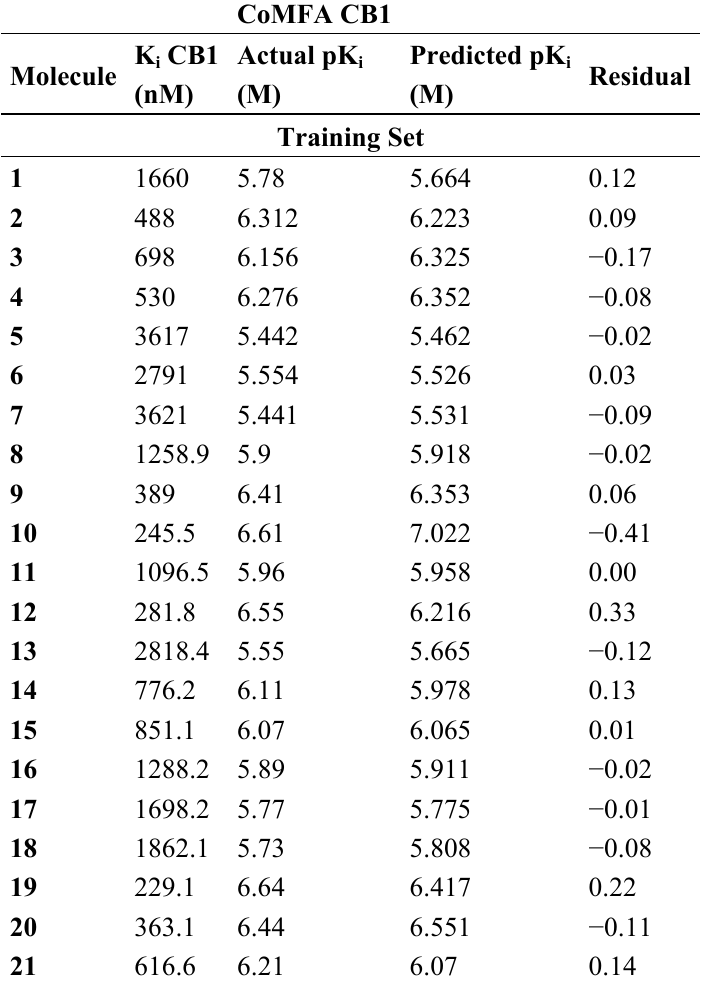
Table 2. Experimental and predicted activity for training and test set in the CB1 and CB2 models a